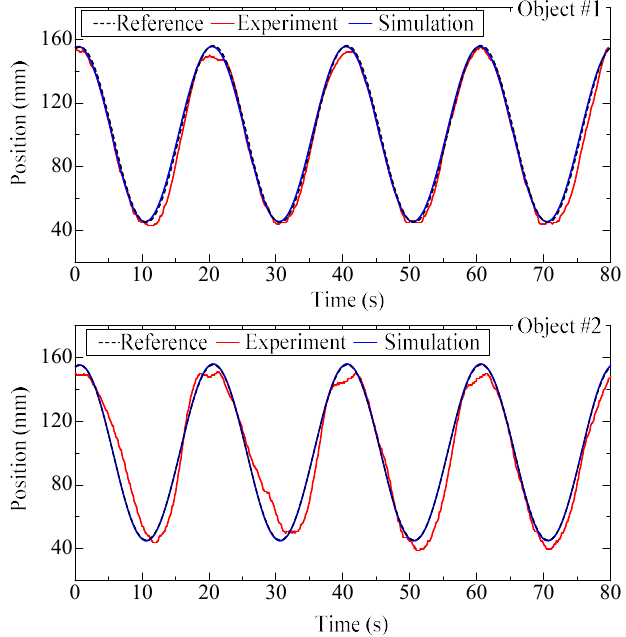
Figure 18. Simulated and experimental results for position tracking.